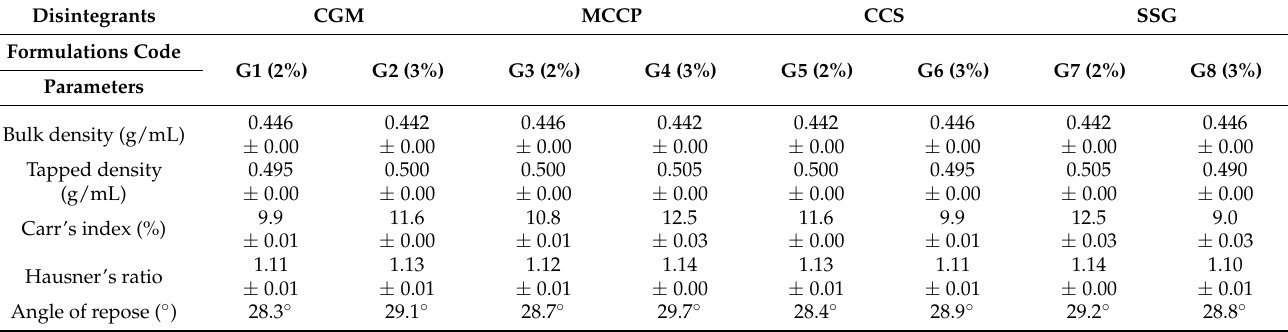
Table 8. Flow properties of formulated granules (Disintegrating agents).